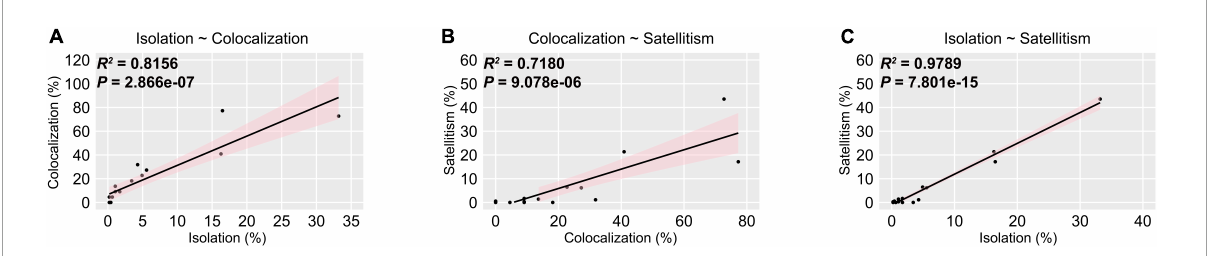
FIGURE3 Isolation is positively correlated with co-colonization and satellitism at genus-level. The pink shaded areas represented the 95% confidence intervals. (A) Isolation is positively correlated with colocalization; (B) Colocalization is positively correlated with satellitism; (C) Isolation is positively correlated with satellitism.